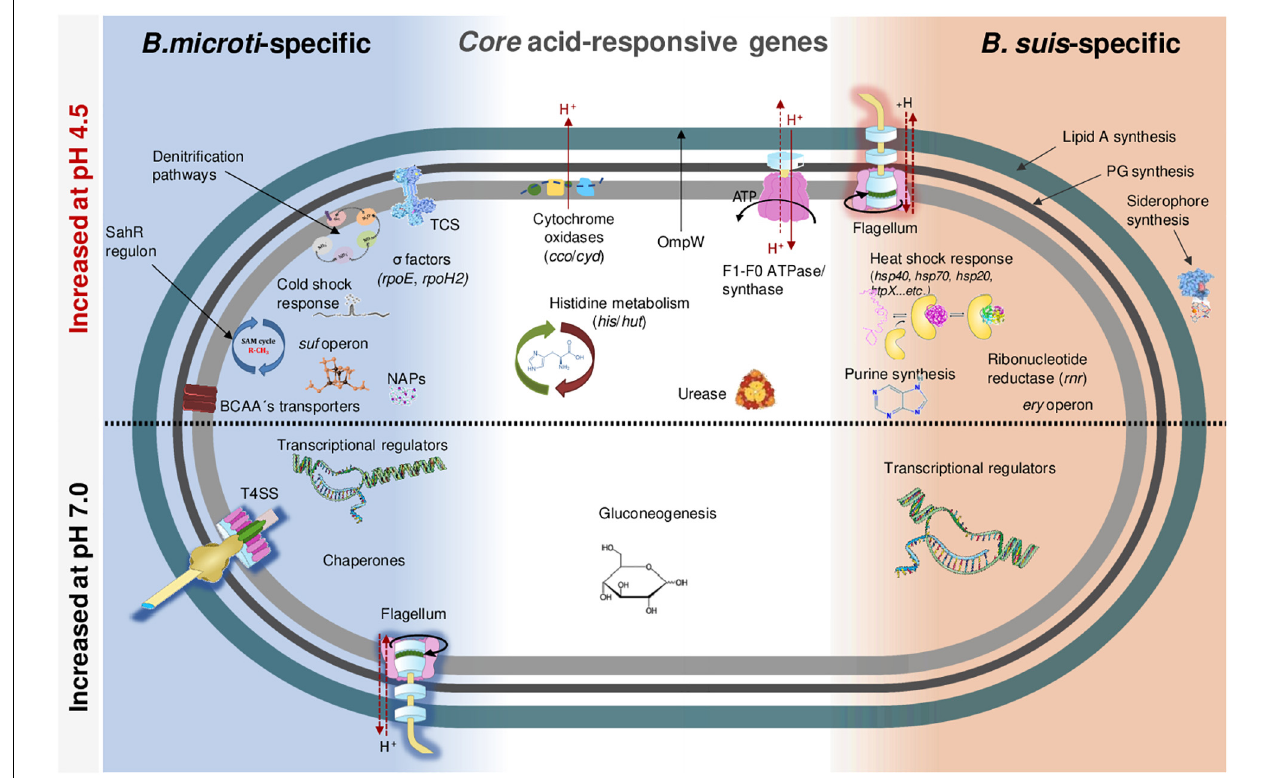
FIGURE 9 | Schematic representation of the highlighted common and species-specific responses for both Brucella species. For the experimental time points chosen, genes with higher expression at pH 4.5 are shown in the upper half, those with higher expression at pH 7 in the lower half of the